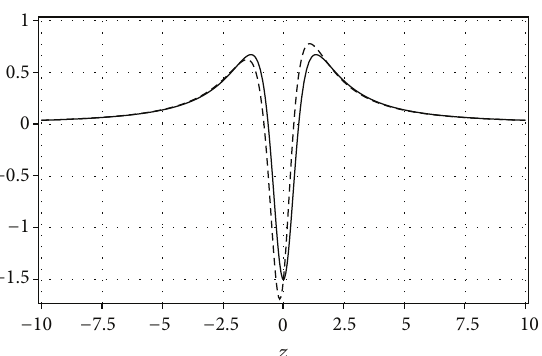
Figure 7: Plot of the quantum mechanical potential in (30a) and (30b), for 𝑐 = 0 (solid line) and 𝑐 = 1/5 (long dashed line).